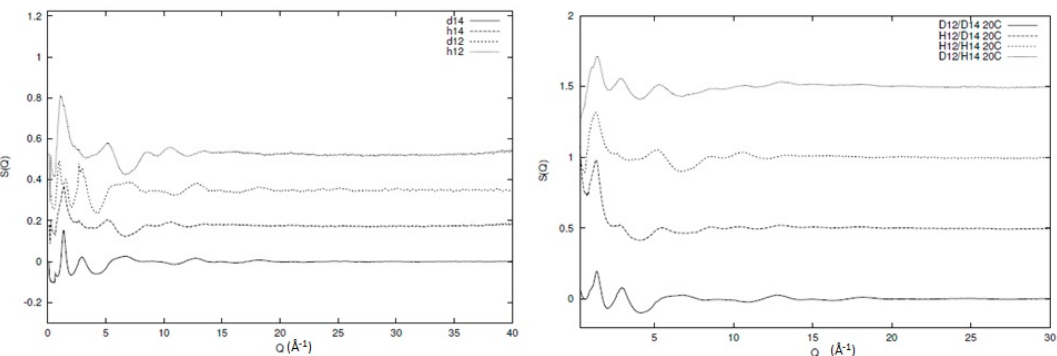
Figure 3. Experimentally observed structure factors of protonated and deuterated 1,2 and 1,4 polybutadiene (left) and blends consisting of these components (right). In both graphs, the term d or h indicate the deuterated or protonated system, respectively, and the term 1,2 or 1,4 indicate the stereoregularity of the polybutadiene chain, respectively.